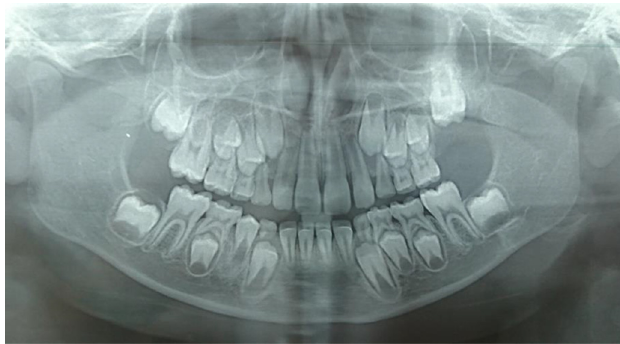
Fig. 2. Orthopantomogram: Tooth 26 is impacted with a mix of radiolucent and radiopaque lesions above.